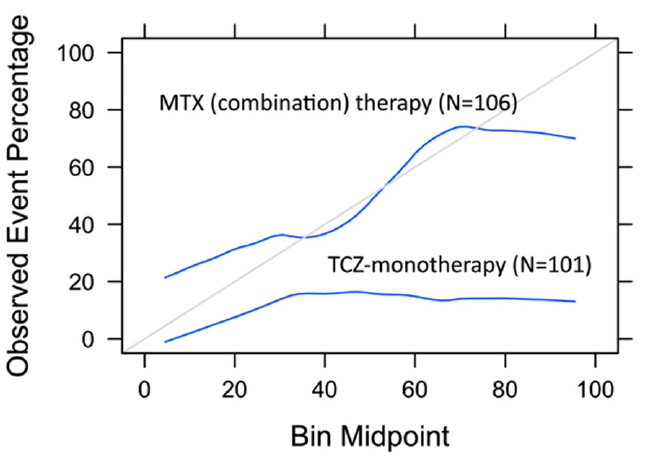
Figure 3. Calibration curves on test set of MTX (combination) therapy group and TCZ-monotherapy group. Logistic regression with six features (i.e., BMI, HAQ, smoking, ESR, TJC28, DMARD/corticosteroid use) was used to create calibration curves.